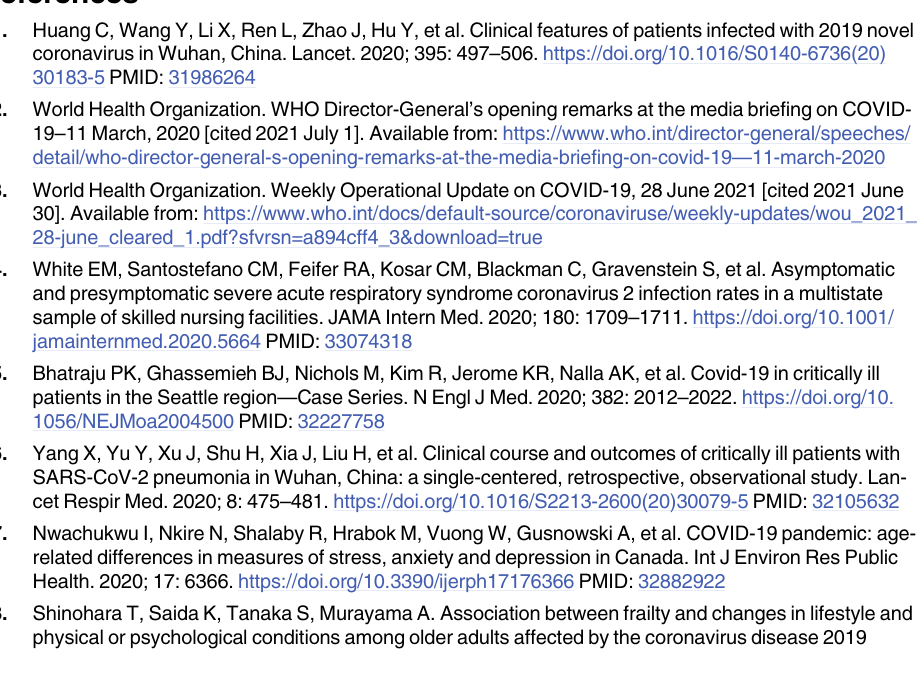
S1 Fig. COVID-19 consultations provided to local residents at pharmacies, by infection risk area. S2 Fig. Main COVID-19 information resources among pharmacists working in health sup- port pharmacies, by infection risk